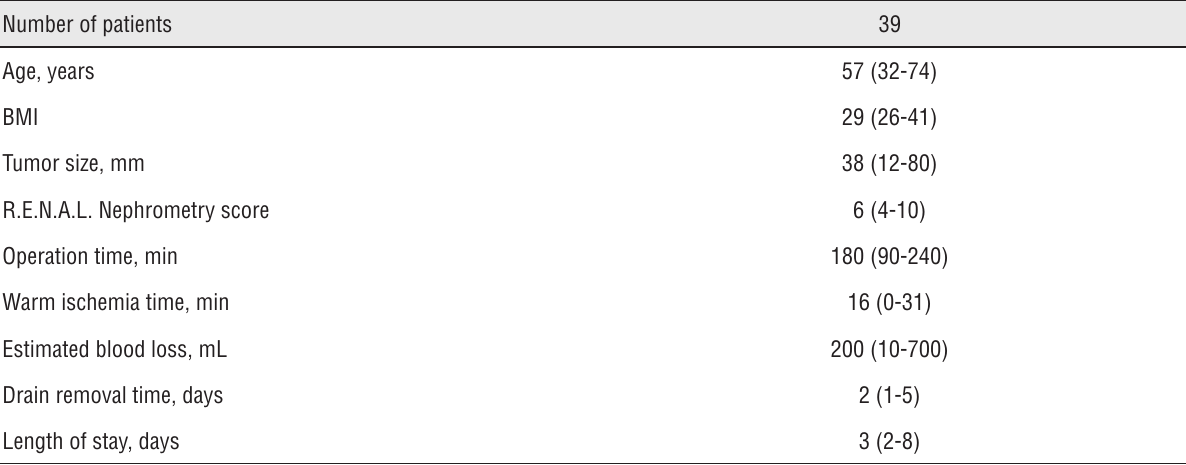
Table 1 - Demographics and operative outcomes of patients. Number of patients